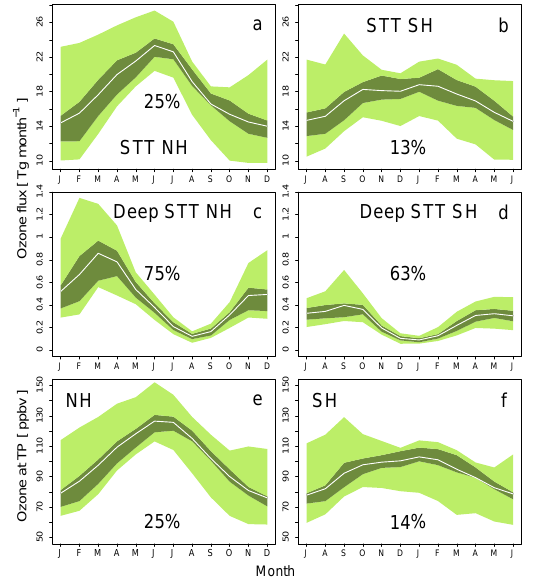
Fig. 18. Seasonal cycles of hemispherically integrated STT ozone flux (top) and deep STT ozone flux (middle) in the NH (left) and SH (right) averaged from 1979 to 2011. The bottom row shows the ozone mixing ratios at the 2pvu/380K dynamical tropopause. The shaded areas show 5th and 95th (light) as well as 25th and 75th (dark) quantiles of the monthly values. The solid white lines show the mean values of the 33yr. The seasonality is quantified by S = max − min , where max and min denote the maximum and min- max + min imum value of the mean cycle. Percentages of S are shown in the individual plots.